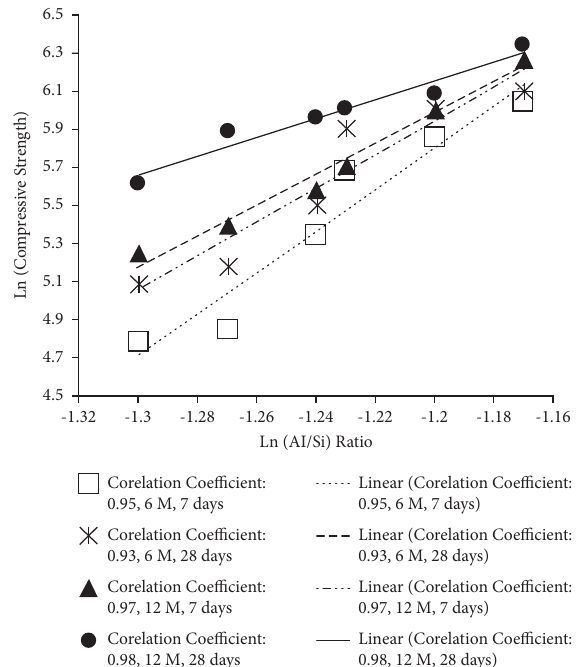
Figure 5: Correlation coefficient between experimental compressive strength and Ln, Al/Si ratio for 6M and 12M samples.